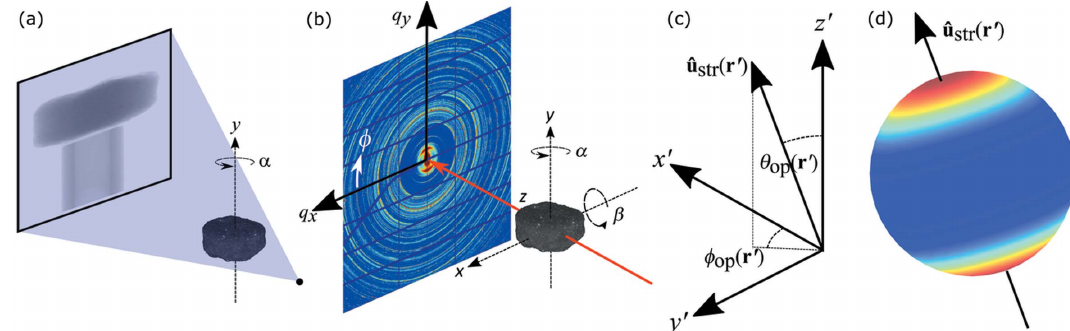
Figure 1 Schematic setups for ( a ) home-laboratory cone-beam attenuation-contrast CT and ( b ) synchrotron parallel-beam XRD-CT. ( c ) A sample coordinate system r 0 = ( x 0 , y 0 , z 0 ) T defined such that the z 0 axis is parallel to the laboratory frame y axis. The local preferred orientation for each sample voxel is described by uˆ str ( r 0 ). ( d ) An illustration of a uniaxial scattering intensity distribution for a single sample